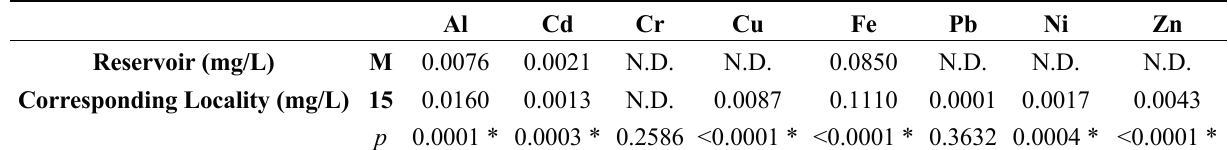
Table A10. Statistical variation between Reservoir M and its feeding Locality 15.